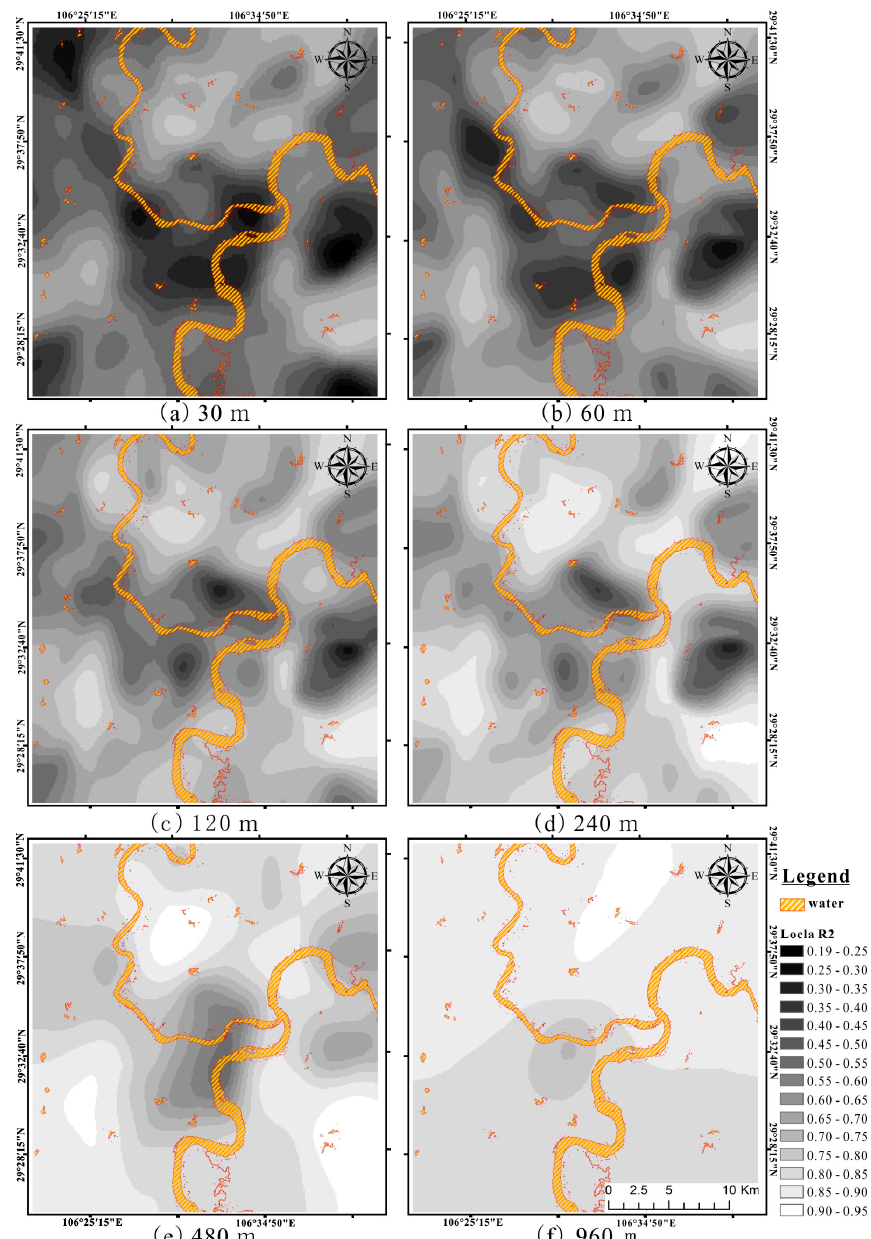
Figure 5. The spatial distribution of the local R 2 in the multi-factor GWR models (using the SAVI, IBI, and NDSI as the explanatory variables simultaneously) at different spatial resolutions, ( a – f ) represent the spatial resolutions of 30 m, 60 m, 120 m, 240 m, 480 m, and 960 m, respectively. Moreover, the yellow area represents water.